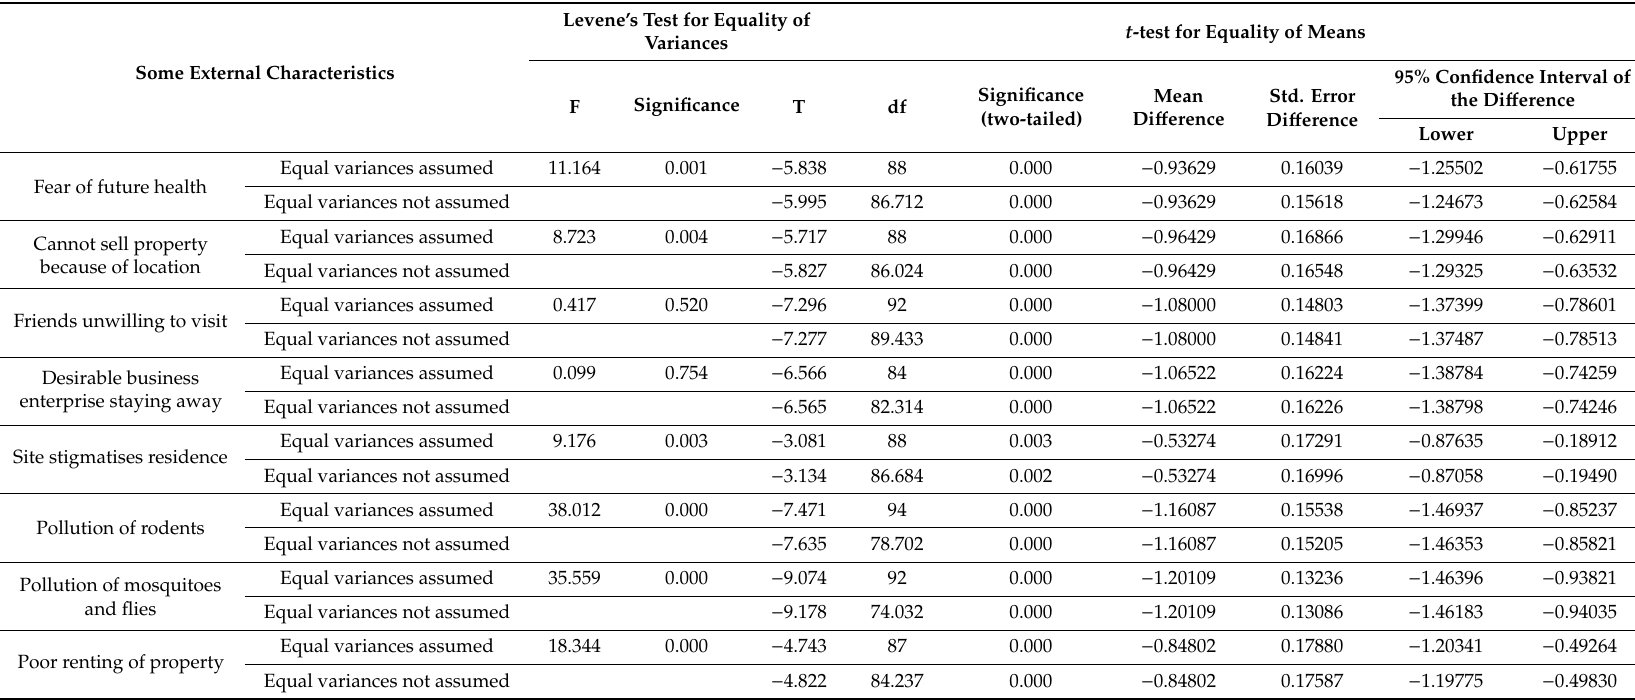
Table A3. Independent samples test on external characteristics observed by the participants living in both